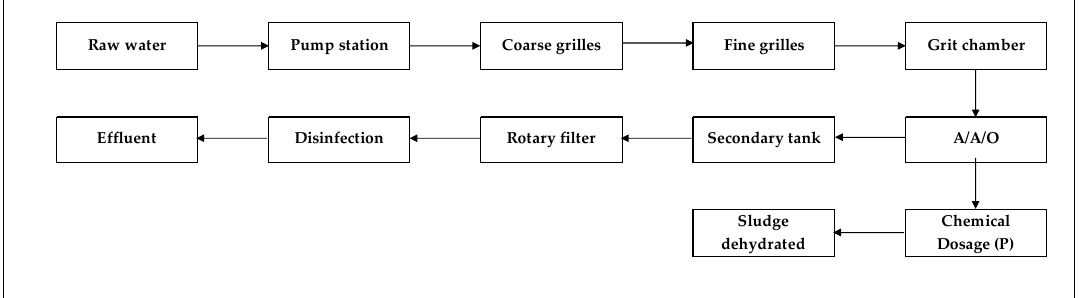
Figure 1. Treatment process of the plant before renovation. Table 3. Main pollutant indicators of the influent and effluent from the wastewater treatment plant (WWTP) before renovation *.